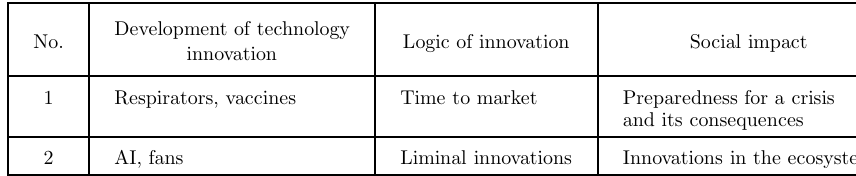
Impact of technology development during the Covid-19 crisis on the society Development of technology